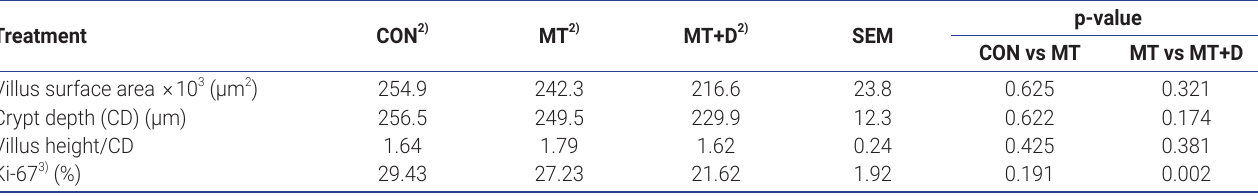
SEM, standard error of the mean; DDGS, dried distillers grains with solubles. 1) MT and MT+D diets have 1.9 mg/kg of deoxynivalenol supplemented from mycotoxin contaminated corn